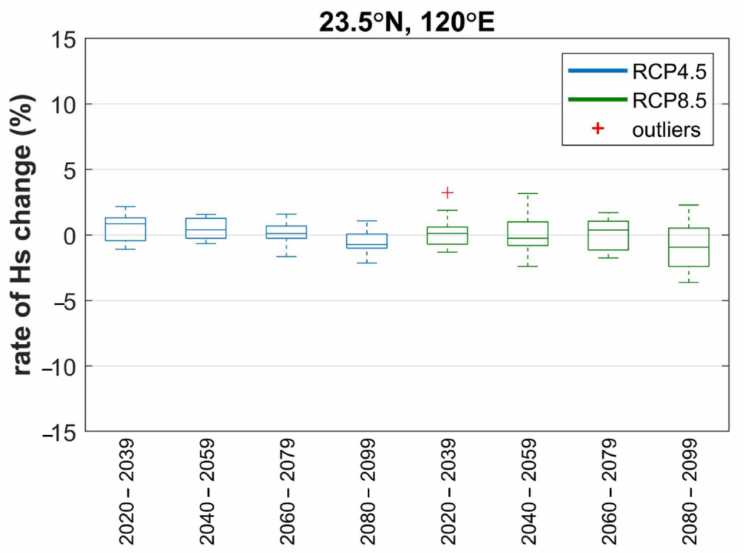
Figure 13. Box plot of rate of change in the averaged significant wave height for each GCM, with respect to the reference period from 1980 to 2004 in the region of Taiwan at 24 ◦ N, 120.15 ◦ E for various future periods (2020–2039, 2040–2059, 2060–2079, and 2080–2099) and scenarios (RCP4.5 and RCP8.5).